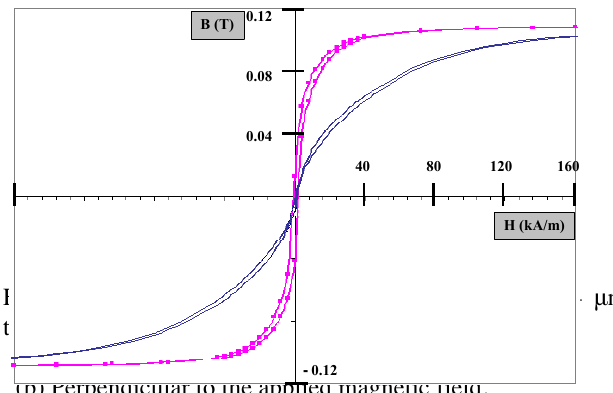
Figure 4: VSM hysteresis cycles for YIG film of 12.4 μ m thickness and annealed at 740 °C for 2